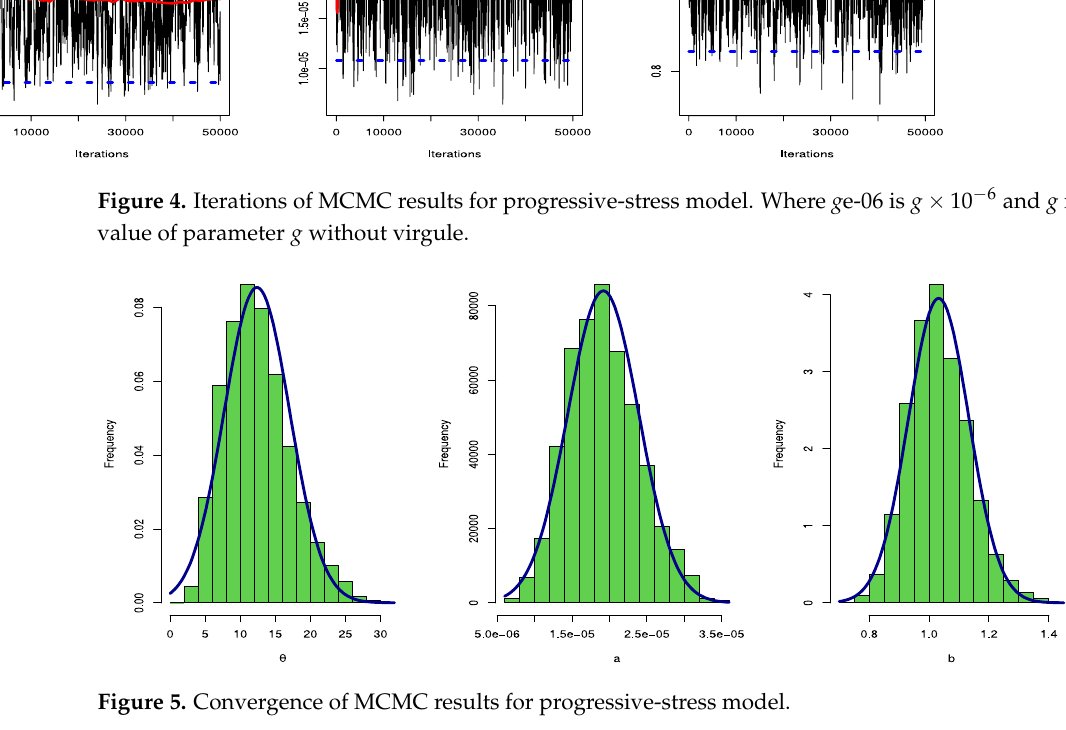
Figure 5. Convergence of MCMC results for progressive-stress model.